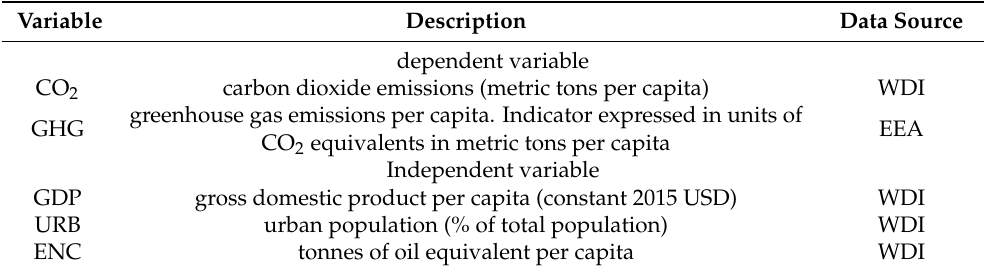
Table 1. Variables descriptions and sources of data.